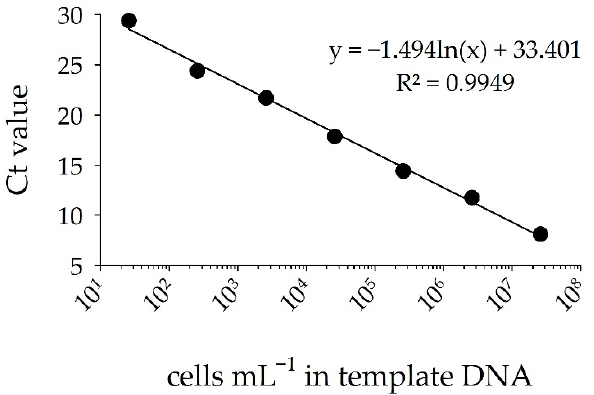
Figure 4. Standard curve of Ct values for tenfold dilutions of known DNA concentration of Raphidiopsis raciborskii T3 (cells mL − 1 ). Error bars provide standard deviations of triplicate amplifications.